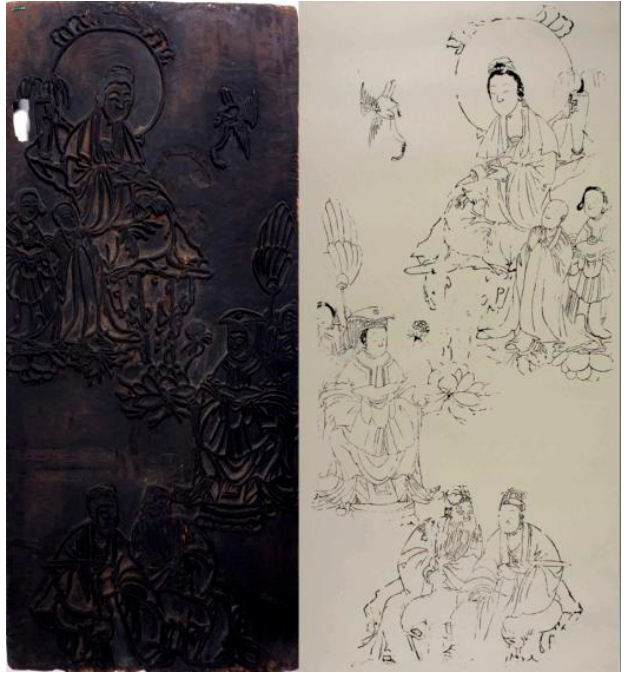
Figure 1. “Guan-yin-ma-lian” provided by the Japan Reference Center. Figure 1. “Guan‑yin‑ma‑lian” provided by the Japan Reference Center.